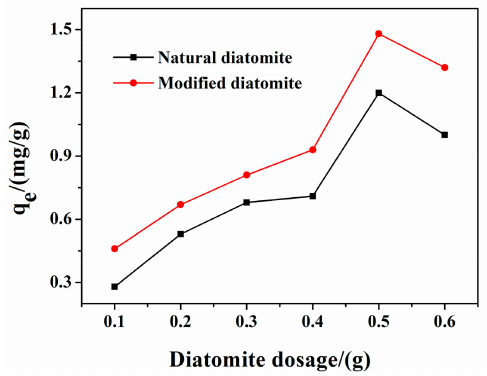
Figure 7. Effect of adsorbent dose on the removal of 1-NAP by modified diatomite.